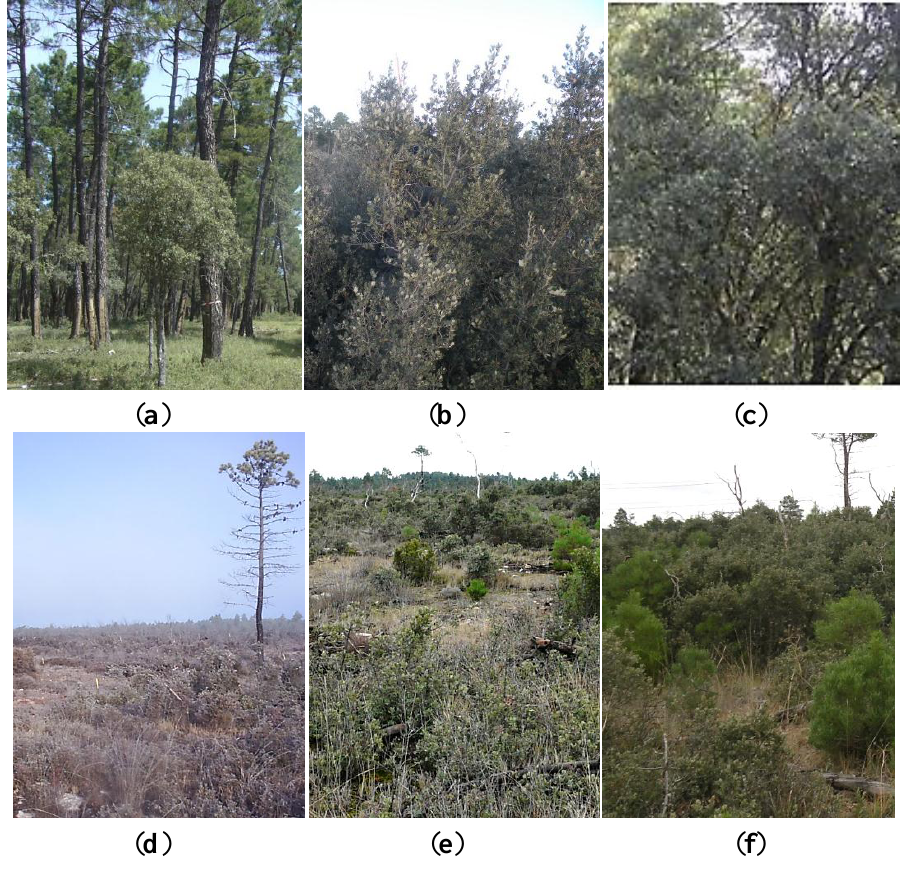
Figure 1. Overviews of: ( a ) pine forest control site (Forest_c); ( b ) shrub control site (shrub_c); ( c ) mature holm oak site; burnt pine forest area six years ( d ), nine years ( e ), and 12 years ( f ) after the